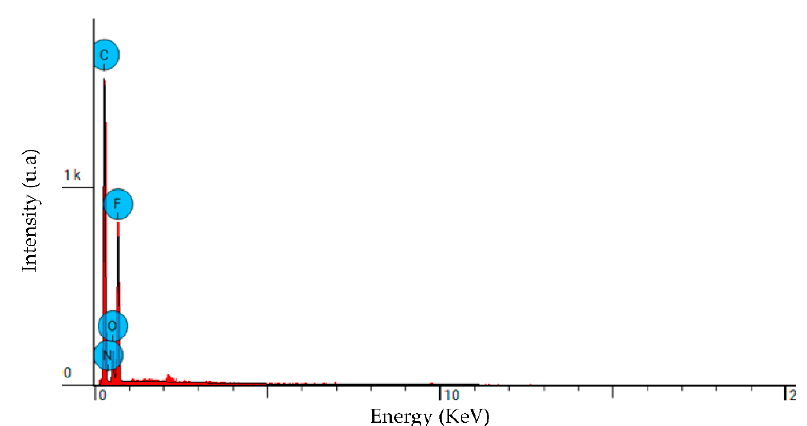
Figure 2. EDS spectrum of the PPC-0.05 modified membrane. Table 3. EDS elemental analysis for modified membranes.